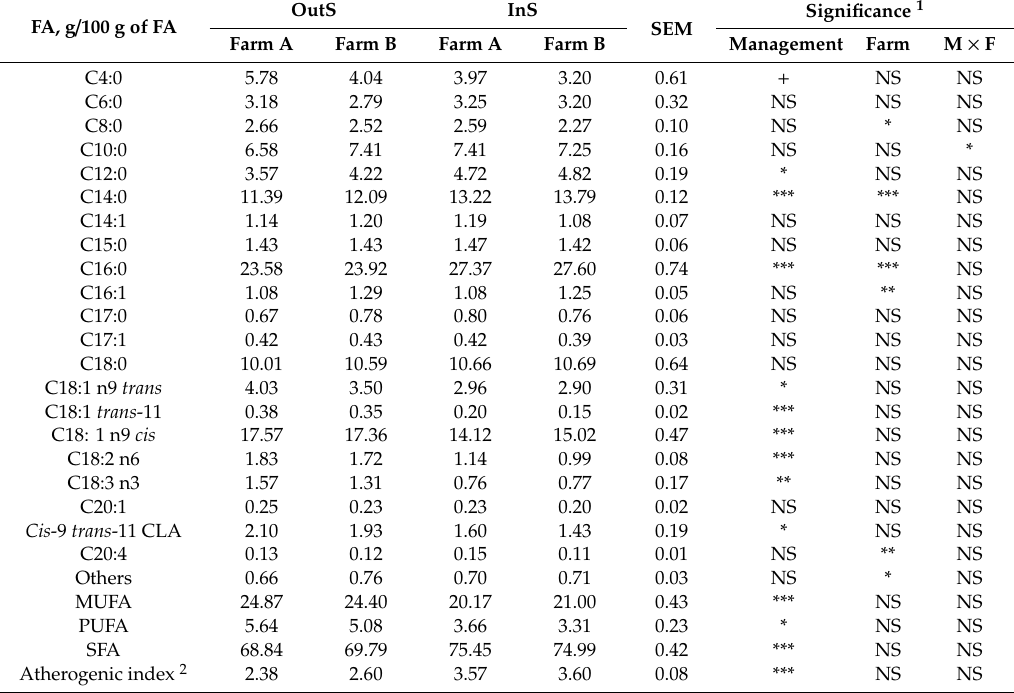
Table 5. Pecorino cheese fatty acids composition as a ff ected by the management system, the farms, and their interaction (LSM ± SEM). FA, g / 100 g of